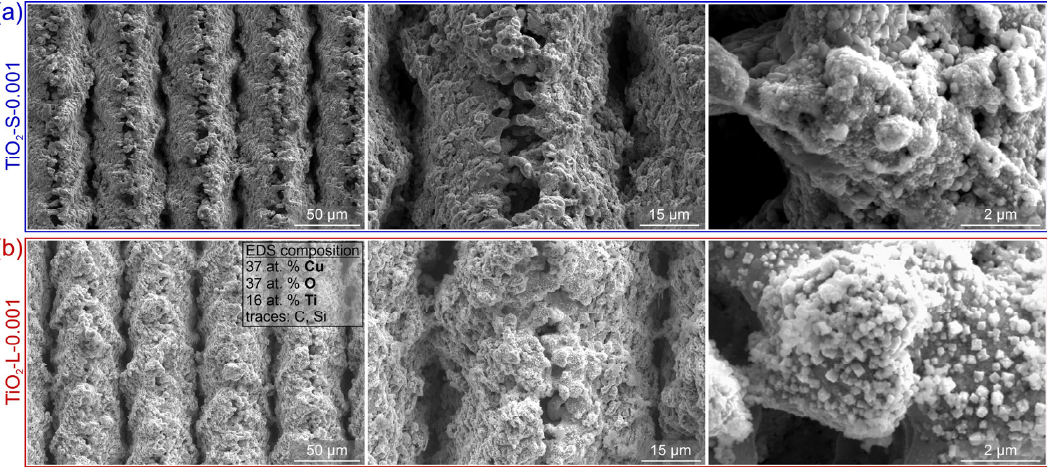
Figure 9. ( a ) SEM images of the laser-textured sample LT after exposure to boiling 0.001 wt.% nanofluid with small nanoparticles (i.e., S-0.001) and ( b ) after exposure to boiling 0.001 wt.% nanofluid with large nanoparticles (i.e., L-0.001).